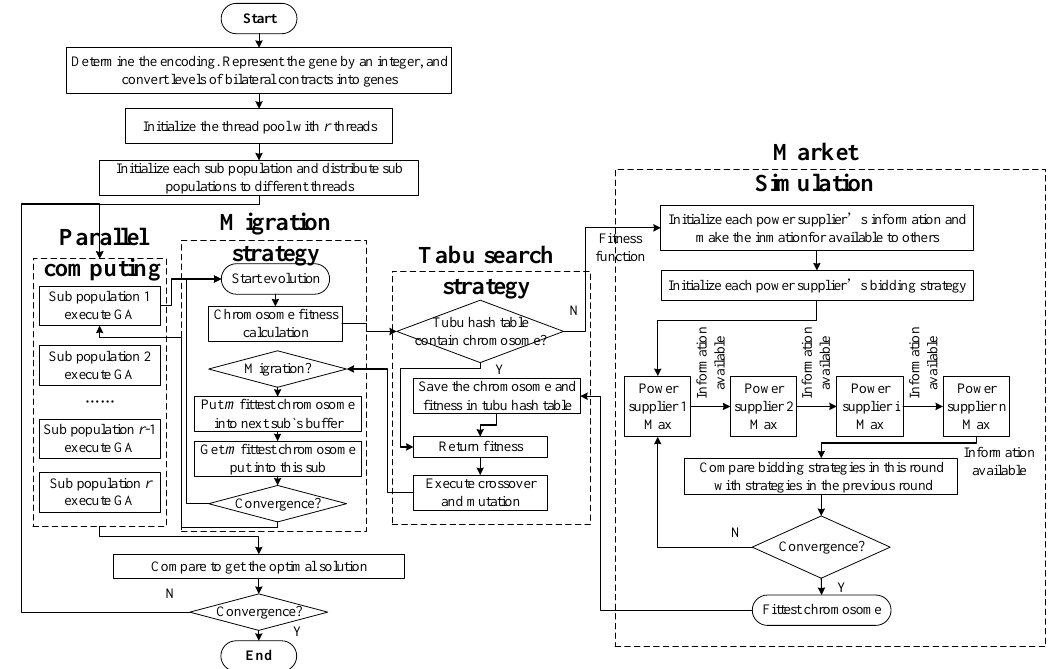
Figure 5. Integrated solution methodology based on a multi-core parallel tabu genetic algorithm (MPTGA).